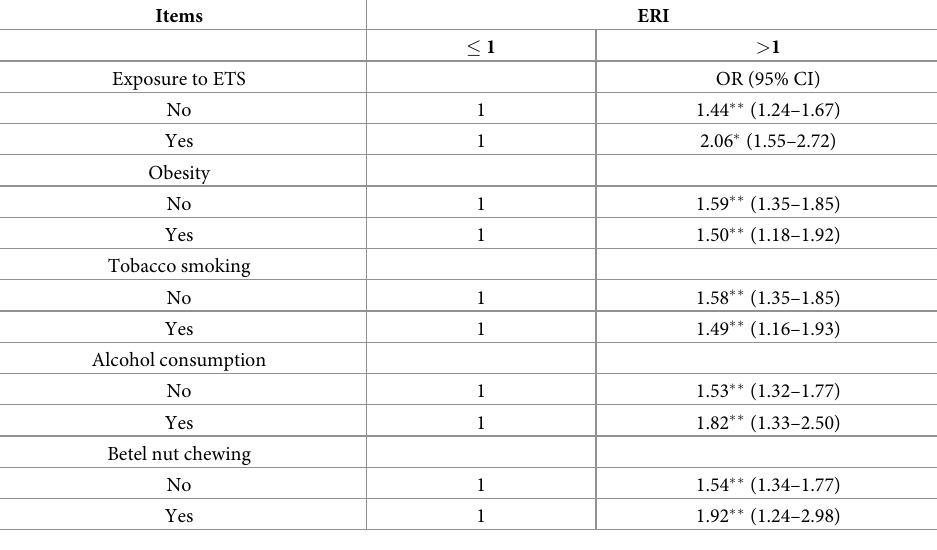
Table 3. ERI levels associated with risks of hyperlipidemia for exposure to ETS, obesity, tobacco smoking, alcohol consumption, and betel nut chewing using multiple logistic regression adjusted for gender, age, education level, income, and marital